Question: Briefly state, in one sentence, what is plotted here.
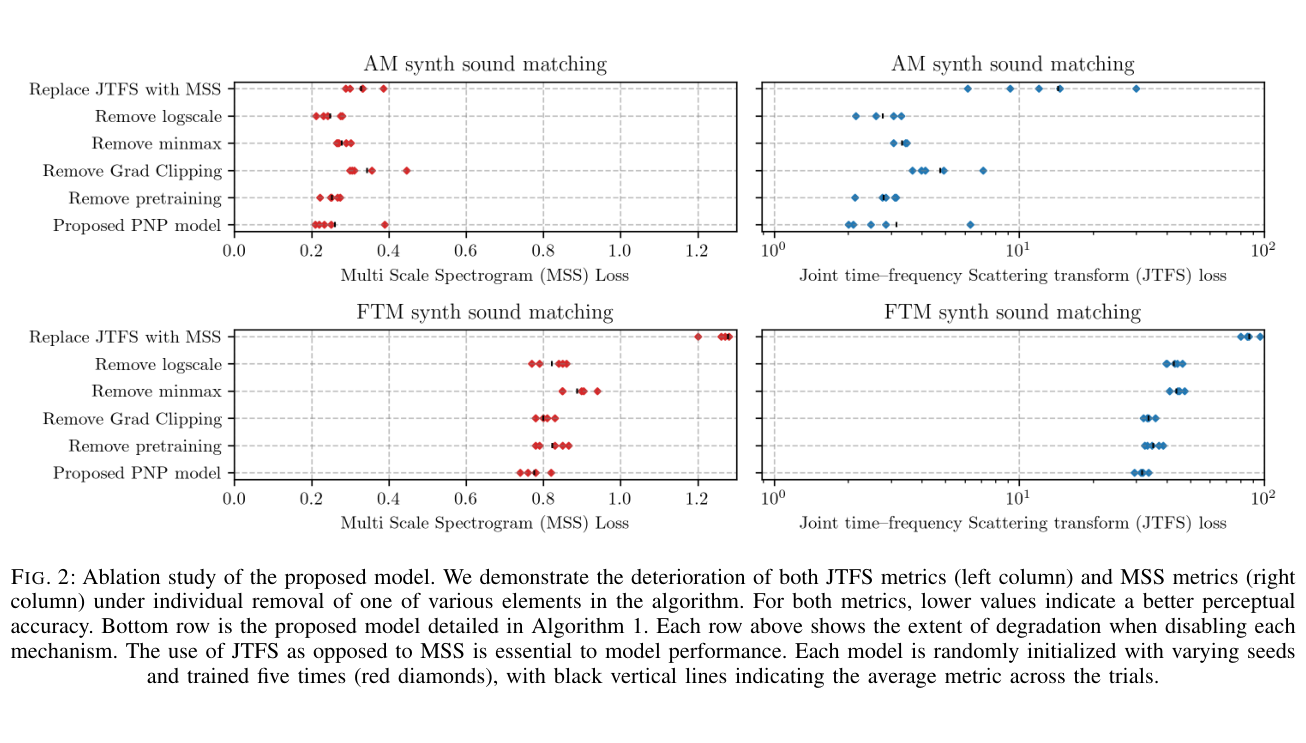
Answer: that both scaling operations help ease the retrieval. For both AM/FM arppegiator and FTM drum synthesizer, min–max scaling contributes more to the improvement of model convergence than does logarithmic transformation. Even though removing logarithmic transformation results in inad- equate scaling that further deviates from linear correlation with perceptual difference, the min–max scaling still con- fines the parameter range and in turn the prediction error. On the contrary, removing min–max scaling while keeping logarithmic transformation induces drastic parameter ranges and poses serious challenge in training the penultimate layer of f W, even if the logarithmic transformation reduces that range discrepancy. This potentially explains the relatively larger degradation in removing min–max scaling when retrieving from FTM drum sounds. 4) Effect of optimizer: The addition of weight decay and gradient clipping has greatly improved the convergence across all models, reducing both